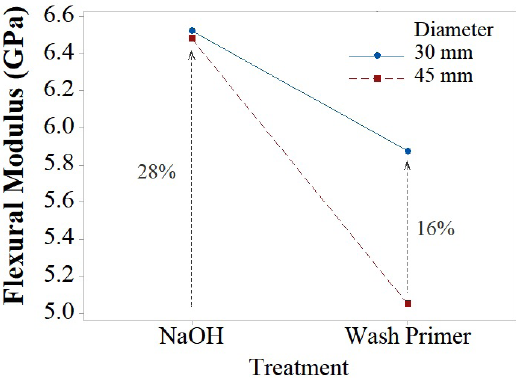
Figure 9. Second order interaction effect plot for the mean flexural modulus.